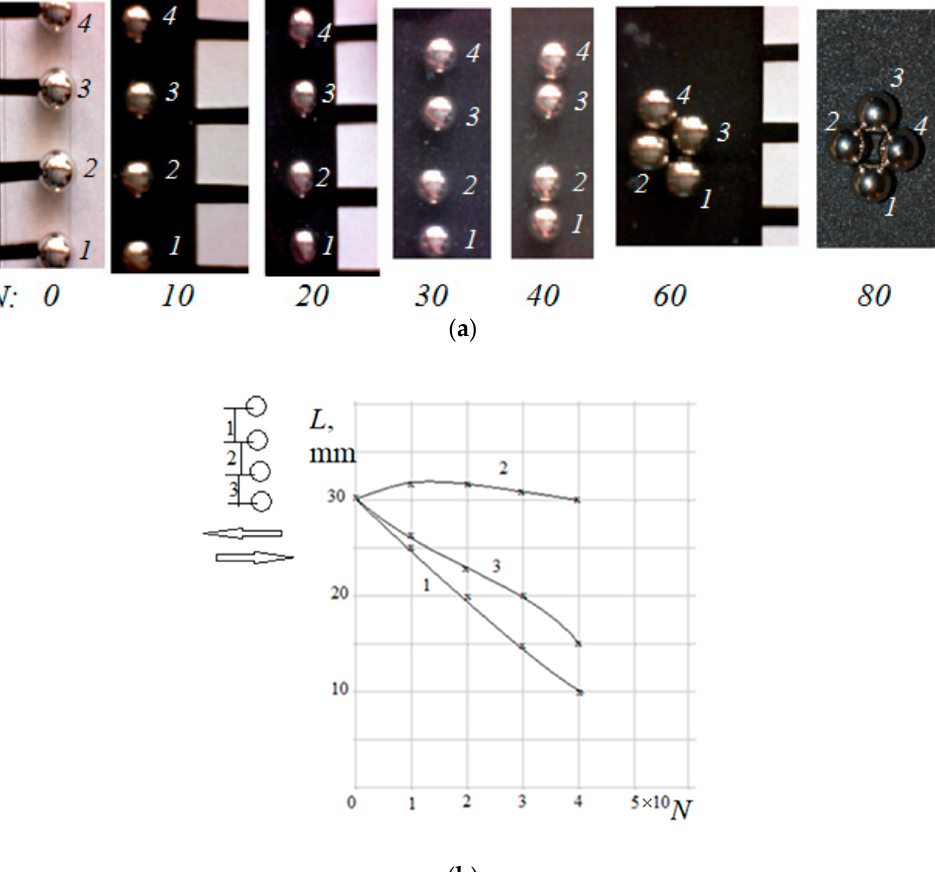
Figure 2. A line of four equidistant balls. The initial distance between the centers in the line was 25 mm. Movement along the line of balls ( a ). Change of the distance between the centers ( b ). N is the number of cycles.